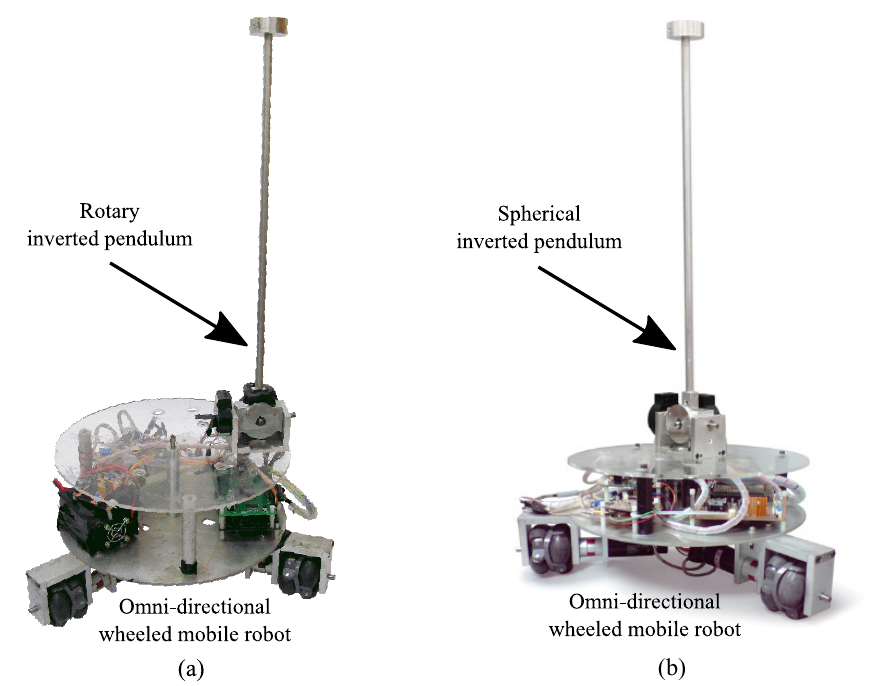
Figure 5. Experimental setup: ( a ) is a rotary inverted pendulum system, and ( b ) is a spherical inverted pendulum